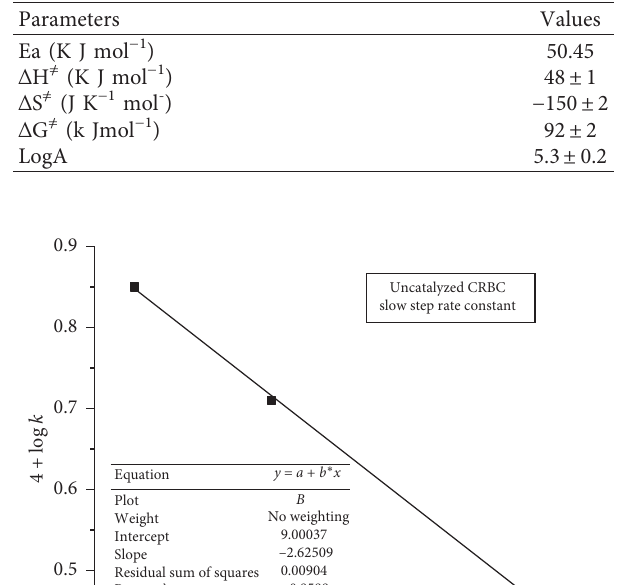
Figure 10: Plot of (4+log k Table 3: Activation parameters with respect to slow step rate constants ( k ).